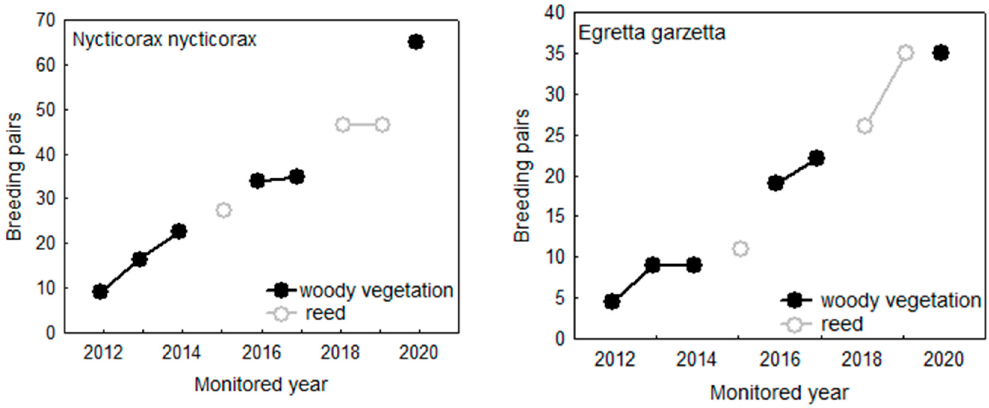
Figure 10. Influence of substrate type (woody vegetation vs. reed) on ( left ) Nycticorax nycticorax and ( right ) Egretta garzetta population trends.